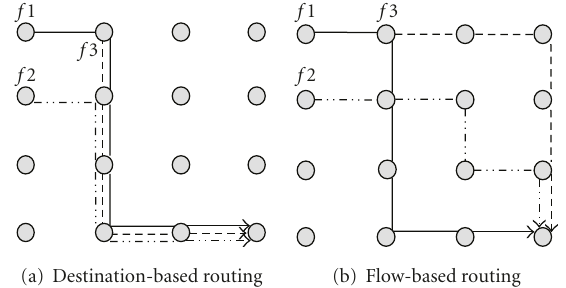
Figure 2: Example of destination- versus flow based routing. f 1, f 2, and f 3 are three ordered flows with the same destination. In (a), all flows share the same path segment from the first common intermediate hop to the destination. In (b), flow based routing permits a better flow distribution in the network, thereby reducing the interference and contention su ff ered by each